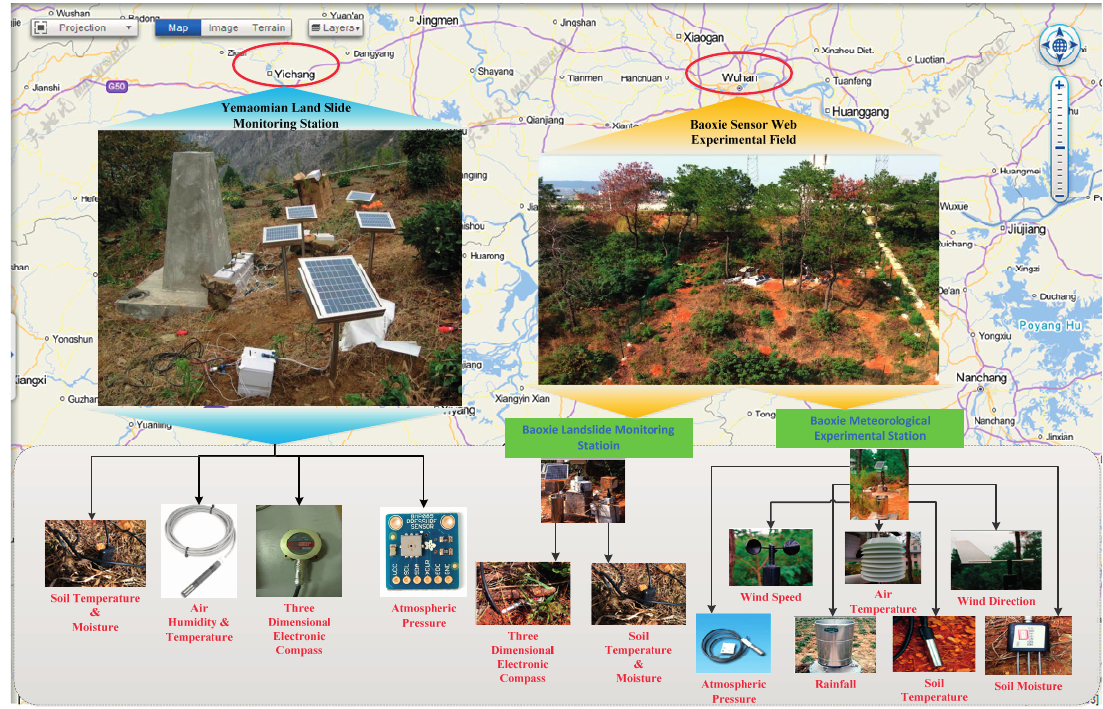
Figure 4. Two scientific experimental